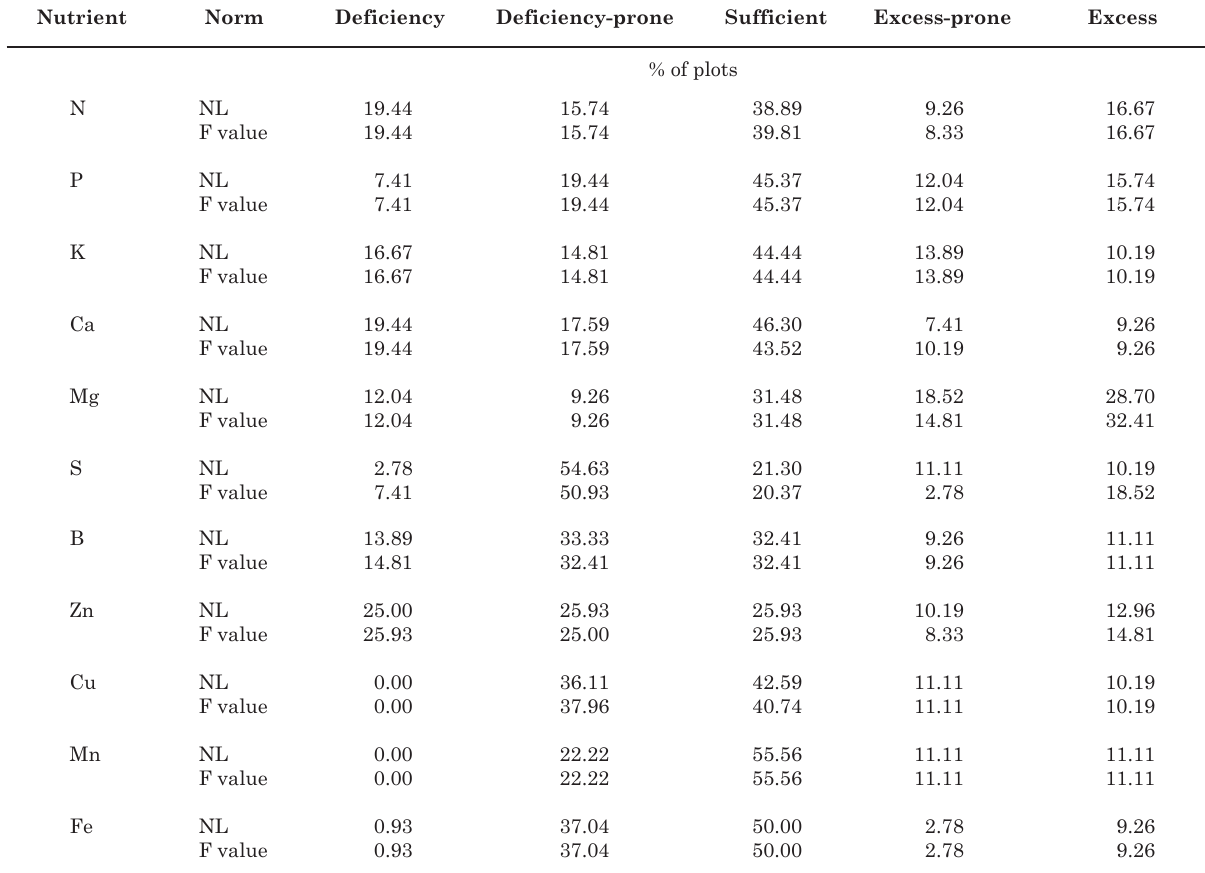
table 5. Percentage of plots diagnosed by Beaufils ranges as deficiency, deficiency-prone, sufficient, excess-prone or excess leaf nutrient contents of cotton, based on the criteria of natural log transfor- mation (nl) and f value